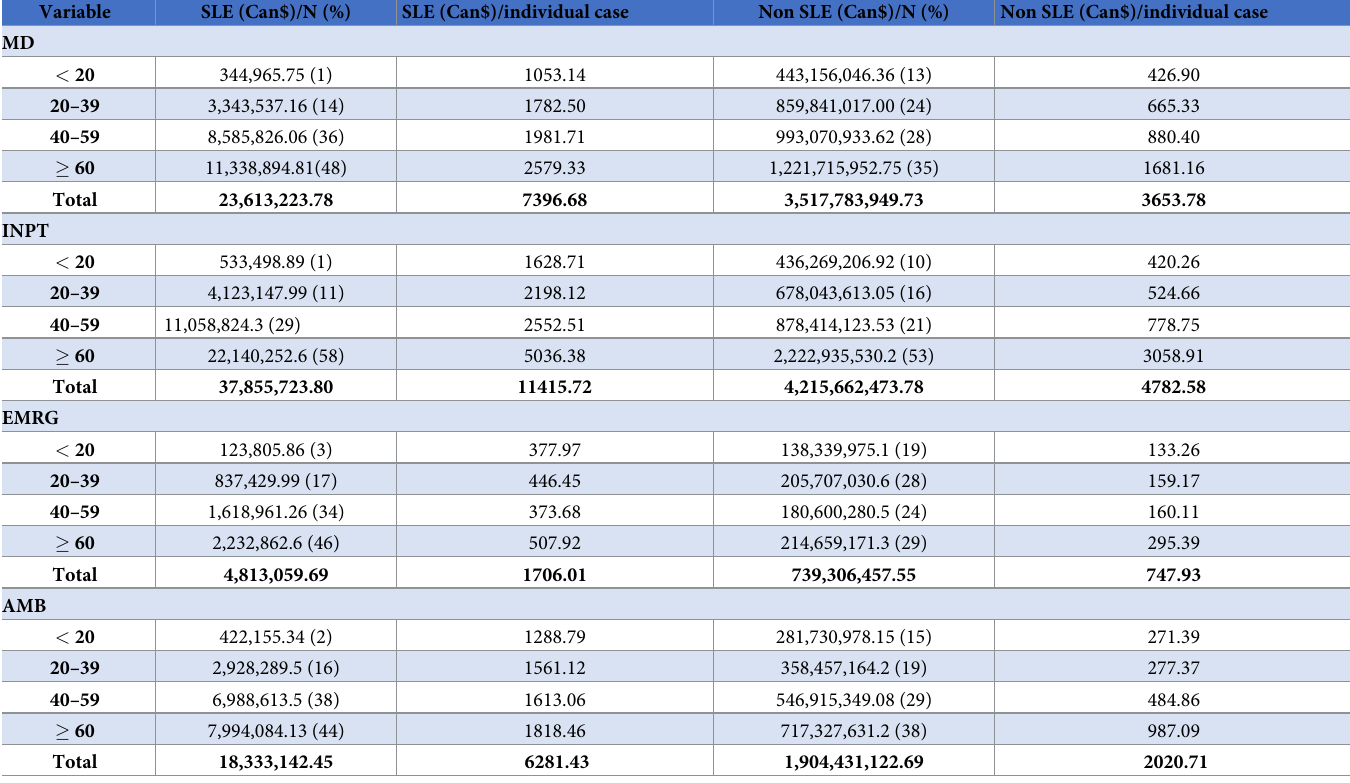
Table 4. Annual costs of SLE and Non SLE per total number of cases/individual case by age group and service of care.